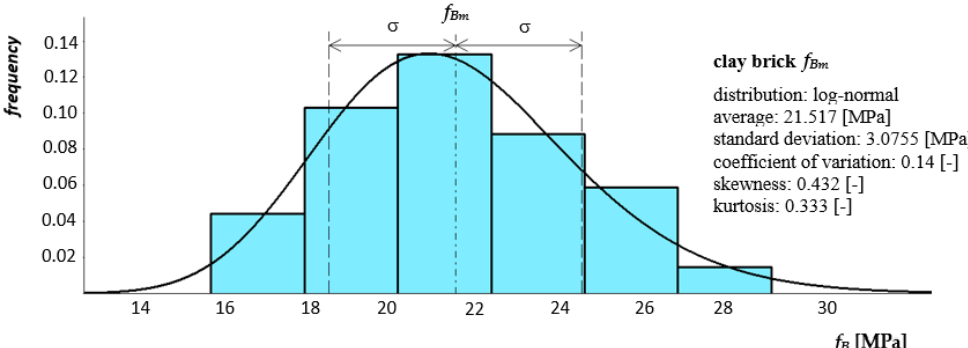
Figure 14. Histogram together with the approximate function of the compression strength distribution of clay brick.